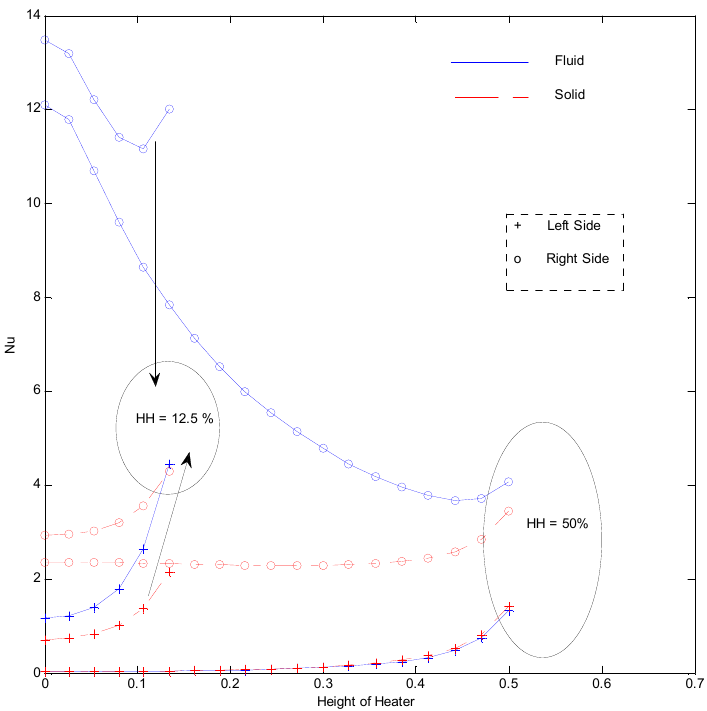
Figure 25. Nusselt number for inner strip at Ra = 100 , H = 5 , Kr = 1 , Rd = 0 for strip at x = 0.5.